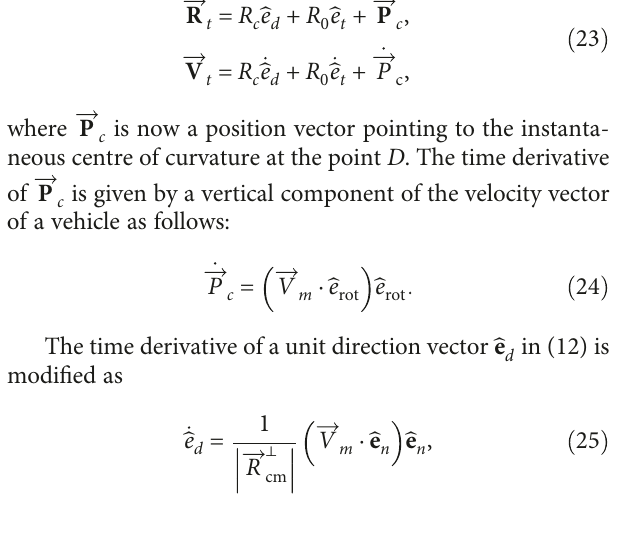
Figure 9: Cross-track